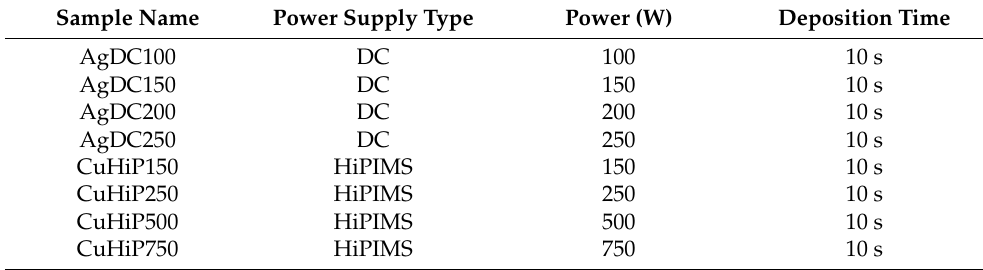
Table 1. Codification of samples depending on type of power supply and power applied to the